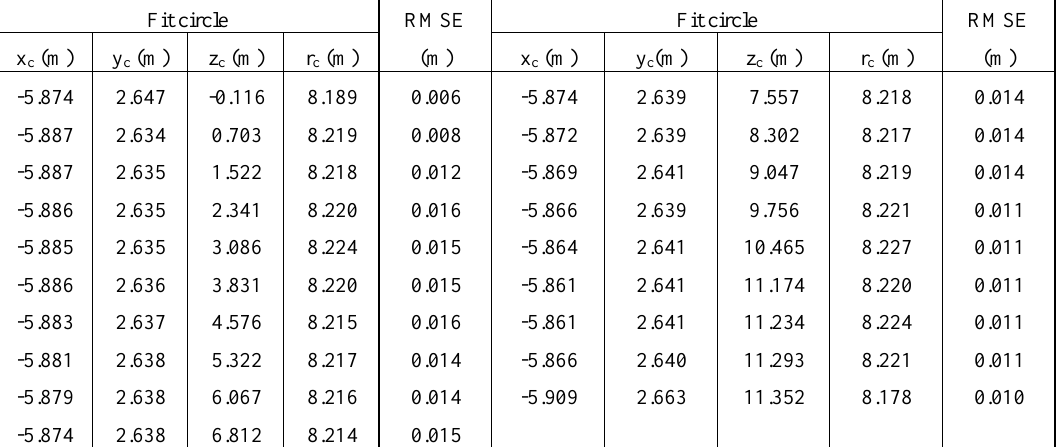
Table 2 . Fitting circles along a vertical direction of a shell wall